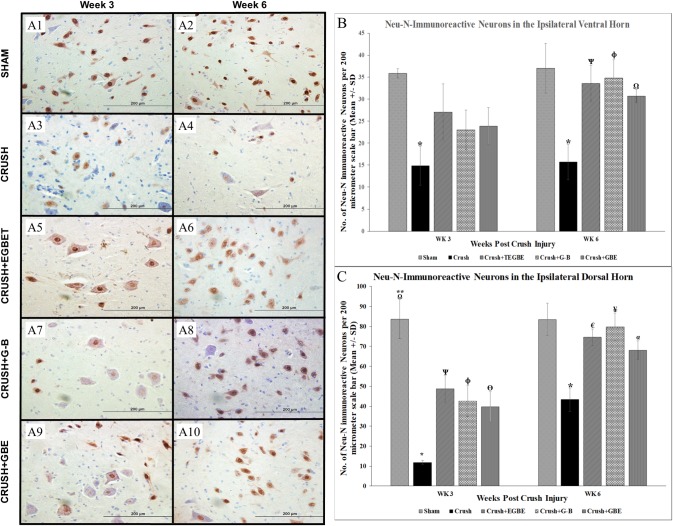
Immunohistochemical analysis.A: Representative photomicrographs (40x objective) of lumbar spinal cord ventral grey horn from rats of all groups immunostained for NeuN (NeuN–Anti-NeuN, Clone A60, Mouse Monoclonal Antibody) at week 3 (A1, A3, A5, A7 and A9) and week 6 (A2, A4, A6, A8 and A10) following nerve crush injury. Note that in the crush group (n = 12) (A3 and A4), there is a remarkable decrease in Neu-N immunoreactive motor neurons compared to sham group (n = 12) (A1 and A2) at week 3 and week 6 post-injury, respectively. However, at week 3 post-injury, the ventral grey horns of the TEGBE (n = 12) (A5), G-B (n = 12) (A7), and GBE (n = 6) (A9)-treated groups show a remarkable increase in the number of Neu-N immunoreactive neurons compared with crush animals (A3 and A4). All the treated groups (A6, A8 and A10) maintained a notable more increase in the number of Neu-N immunoreactive neurons at week 6 post-injury. Scale bar = 200 μm. B, C: Bar graphs showing the average number of total Neu-N immunoreactive neurons in the ventral grey horn (B) dorsal grey horn (C) and obtained from the different experimental groups at week 3 and week 6 following sciatic nerve injury. B: Note the significant decrease in the Neu-N immunoreactive neurons in crush group compared to the sham group at both time points. In contrast, TEGBE, G-B and GBE-treated groups displayed a gradual increase in the mean number of immunoreactive neurons compared to crush group starting at week 3. This increase in the treated group became highly significant by week 6 post-injury. * indicates p<0.004, crush vs. sham group. Ѱ indicates p<0.006, TEGBE-treated group vs. crush group. ɸ indicates p<0.004, G-B treated-group vs. crush group. Ω indicates p<0.02, GBE-treated group vs. crush group. C: Likewise, note the significant (p<0.0001) decrease in NeuN-immunoreactive neurons in the crush group compared to the sham group at both time points. In contrast, all the treated groups with TEGBE, G-B and GBE showed a significant increase in the Neu-N immunoreactive neurons of the dorsal horn compared to crush group starting at week 3 and continued up to week 6 post-injury. * indicates p<0.0001, crush vs. sham group. ** indicates p<0.005, sham vs. G-B and GBE-treated group. Ω indicates p<0.03, sham vs. TEGBE group. Ѱ indicates p<0.0.002, TEGBE-treated group vs. crush group. ɸ indicates p<0.006, G-B-treated group vs. crush group. ϴ indicates p<0.02, GBE-treated group vs. crush group. ¥ indicates p<0.0001, G-B-treated group vs. crush group. € indicates p<0.003, TEGBE-treated group vs. crush group. α indicates p<0.01, GBE-treated group vs. crush group. Data are expressed as means ± SD (One-way ANOVA, Bonferroni’s multiple comparison tests; n = 6 sections/group).